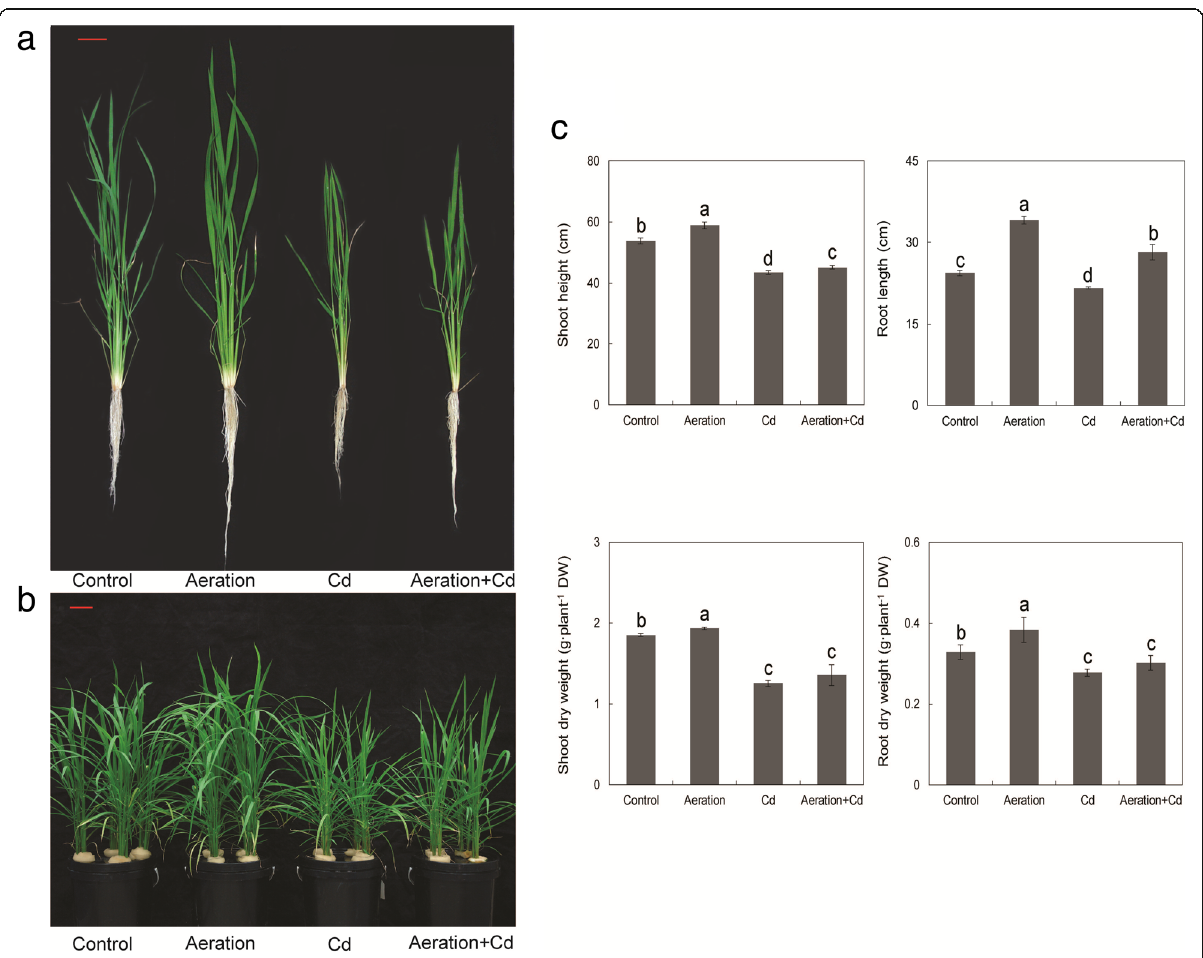
Fig. 1 Effects of aeration or/and 50 μ M CdCl 2 treatments on the growth of rice seedling. a Intact seedling growth phenotype, bar indicates 5 cm; b Hydroponic culture condition, bar indicates 5 cm; c Shoot height, root length, shoot dry weight and root dry weight of rice seedlings. The 3- week-old rice seedlings under hydroponic culture were aerated with air pump (30 min per hour) in the absence or presence of 50 μ M CdCl 2 for 14 d. The values are means ± SE ( n = 8). Different letters on bar indicate significant differences at P <